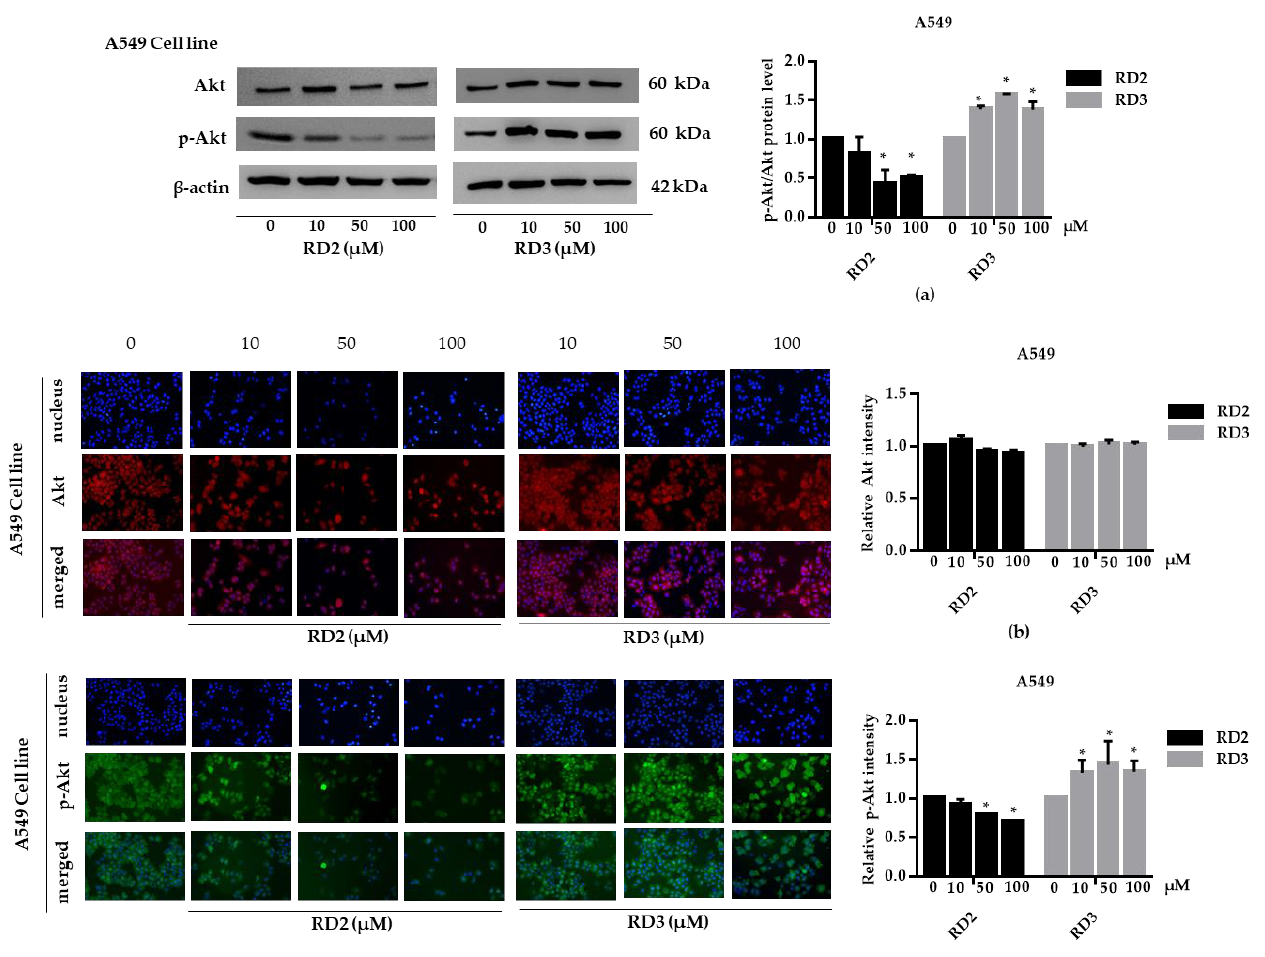
Figure 6. RD2 downregulates p -Akt in NSCLC cells (A549). The cells were treated with RD2 and RD3 (0 – 100 μM ) for 24 h. ( a ) Western blot analysis was performed to measure the p -Akt/Akt-related proteins. β -Actin protein was evaluated to confirm the equal loading of each protein sample. Densitometry of each protein level was calculated and the results are presented as a relative protein level. ( b ) A549 cells were stained with Akt (red fluorescence) and Hoechst 33342 (blue fluorescence). The expression of Akt was determined by immunofluorescence. ( c ) A549 cells were stained with p -Akt (green fluorescence) and Hoechst 33342 (blue fluorescence). The expression of p -Akt was examined using immunofluorescence. Relative protein levels were quantified by densitometry. Data are represented as the mean ± SEM. * p < 0.05, when compared with the control group.